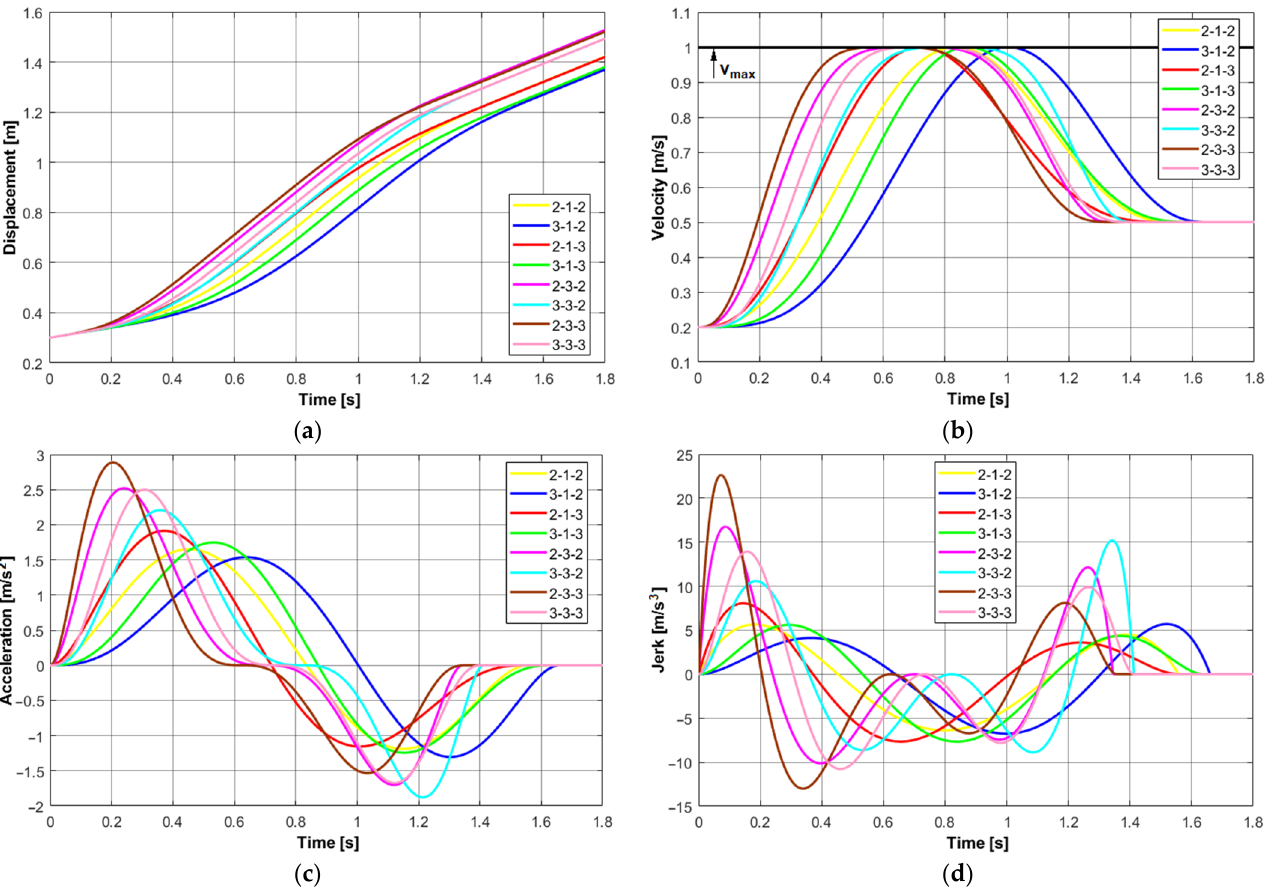
Figure 1. Profiles of kinematic quantities for the trajectories with the velocity constraint: ( a ) displace- ment; ( b ) velocity; ( c ) acceleration; ( d ) jerk.